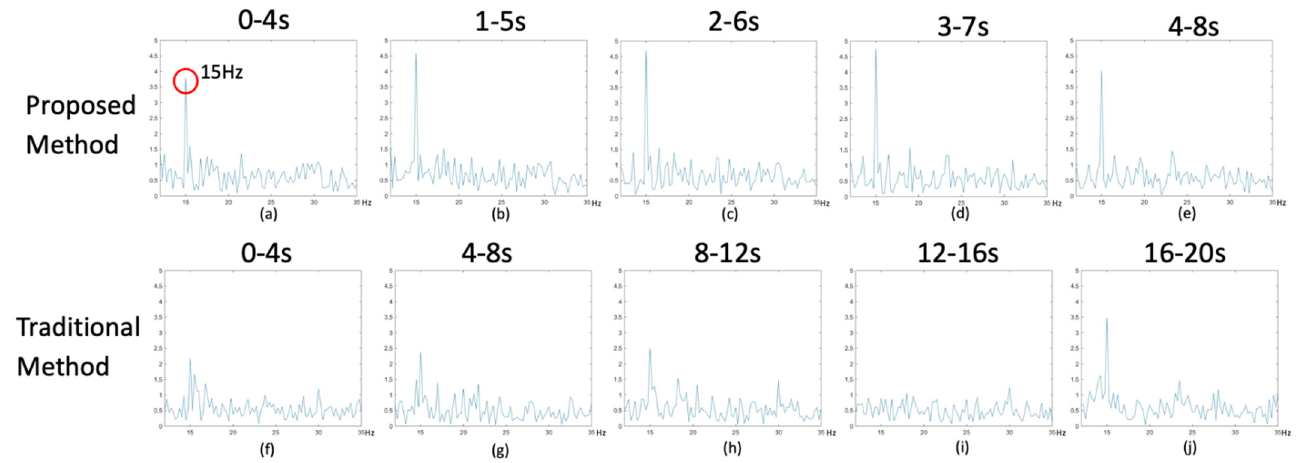
Figure 3. Comparison of the proposed method with the traditional method in 15 Hz brainwave signals.